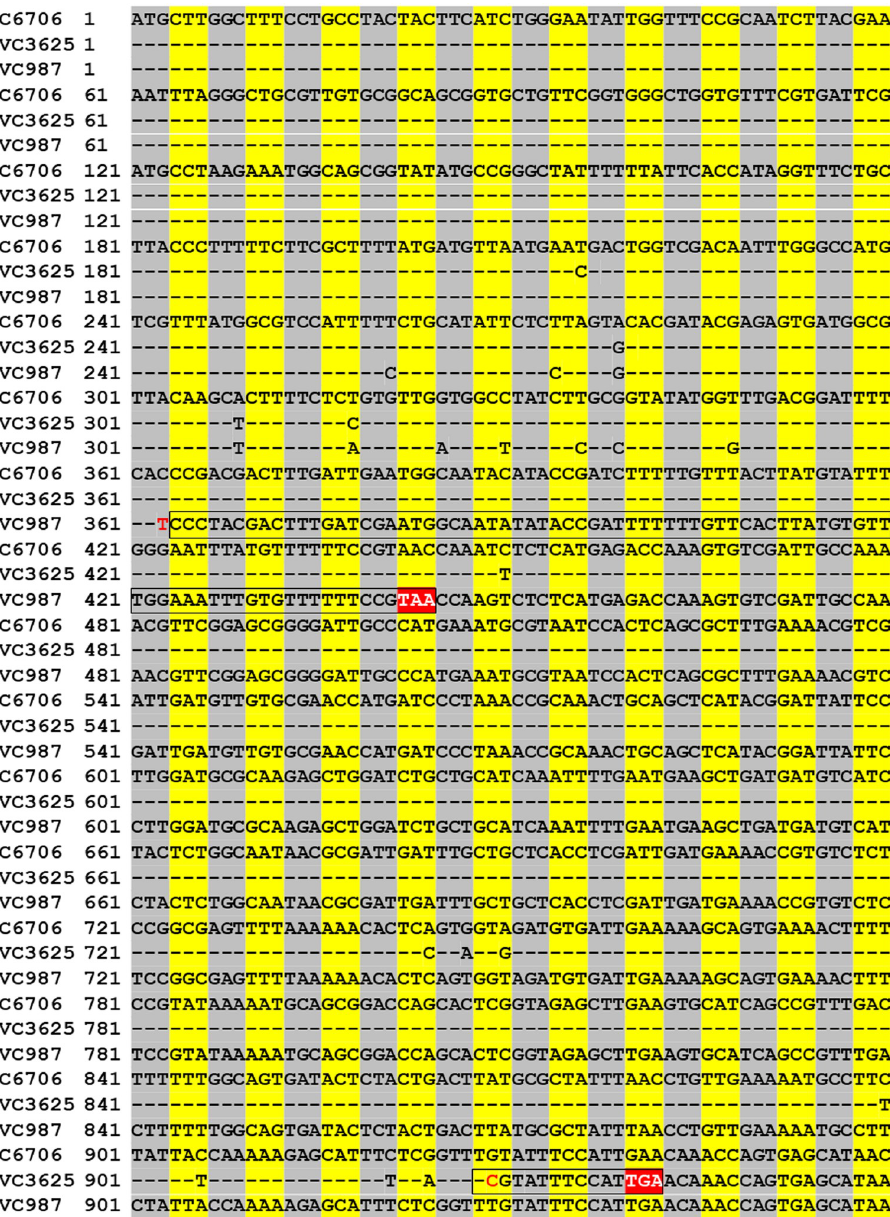
Fig 2. Alignment of the nucleotide sequences of the cqsS gene of strain C6706 with that of two environmental V . cholerae strains VC3625 and VC987 carrying spontaneous mutations in the cqsS gene and overproducing AI-2. The sequence of the coding region from 1 to 960 bases are shown. In the two environmental strains VC3625 and VC987, the cqsS genes are shown to have sustained spontaneous nucleotide insertions at position 353 and 929 respectively (highlighted in red font) resulting in frame shift (black box), and introduction of a stop codon (highlighted in